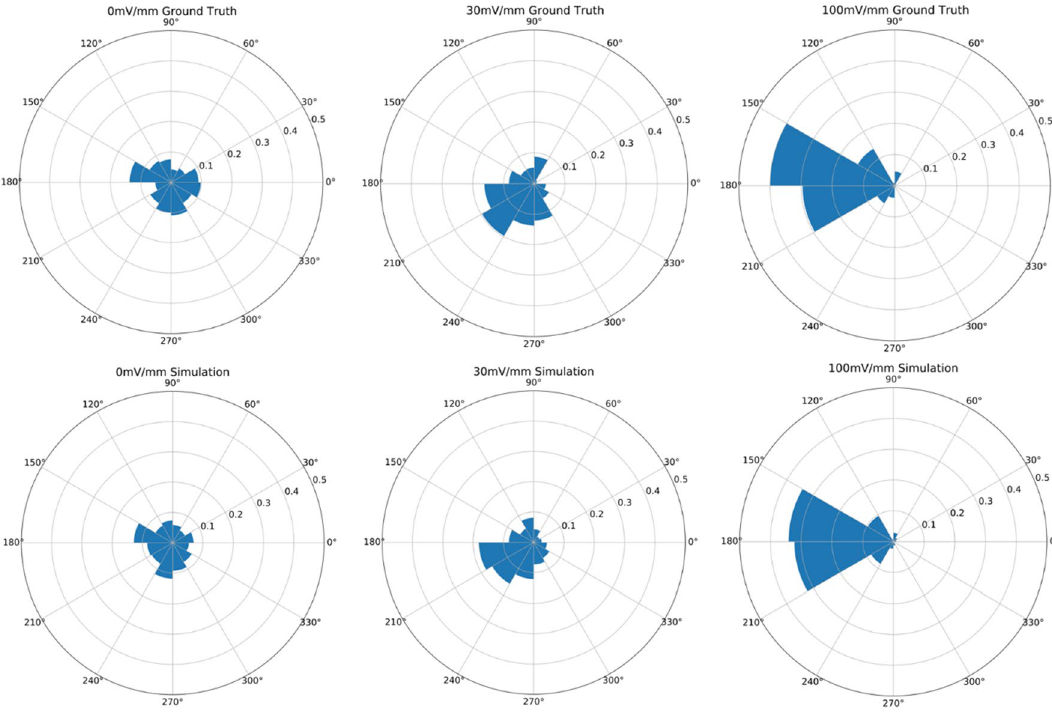
Figure 8. Directional plots for cell migration at various EF for ground truth measurements and in silico simulations with added noise on computed directedness at each time